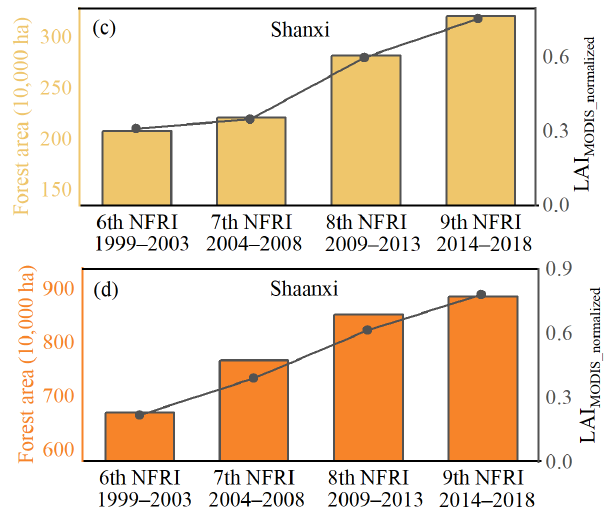
Figure 7. Relationship between the LAI MODIS_normalized trend and forest area for the ( a ) Loess Plateau, ( b ) different provinces, ( c ) Shanxi, and ( d ) Shaanxi. ** represents P < 0.01.